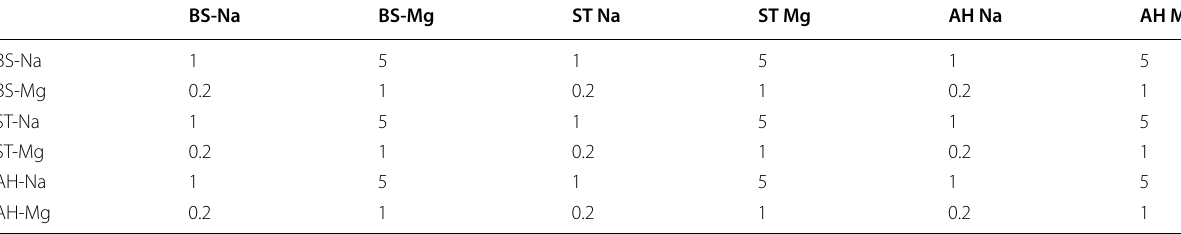
Table 9 Weight judgment matrix used for